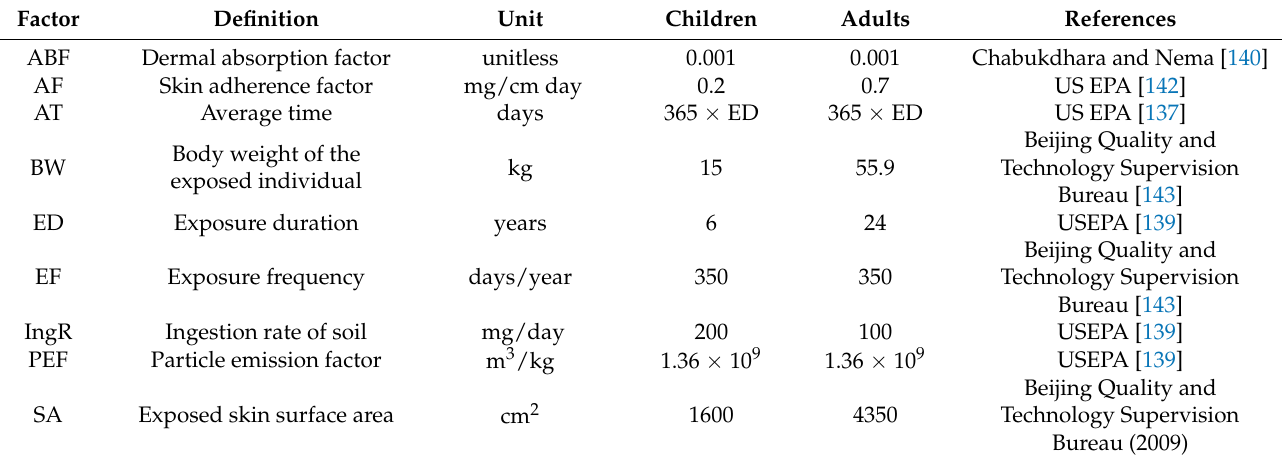
Table 3. Reference values and exposure factors were employed to estimate the intake values and health risks of heavy metals in sediments for the present